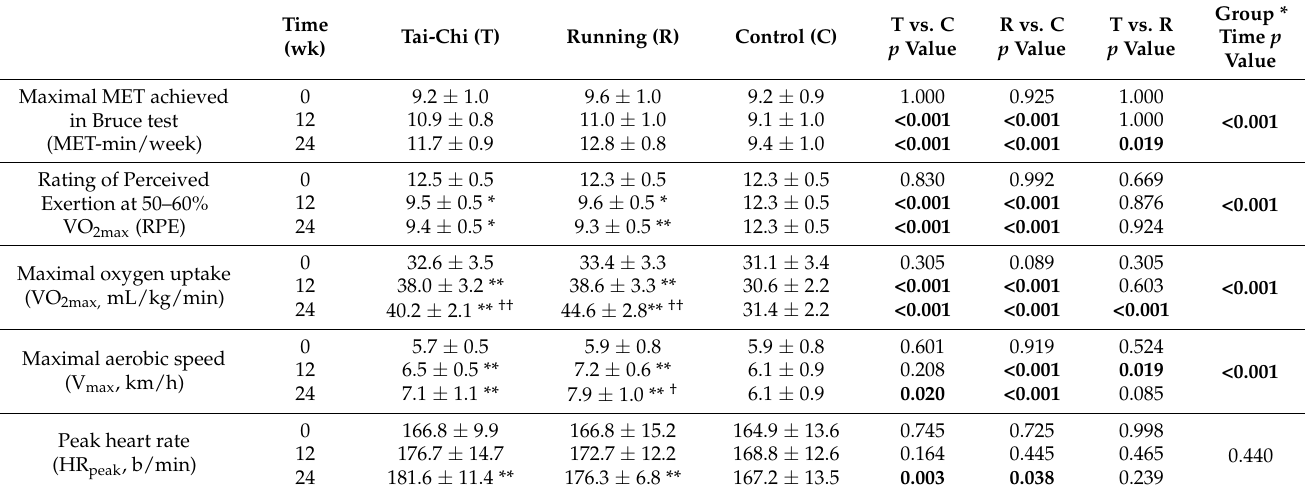
Table 4. Maximal oxygen uptake, maximal aerobic speed and peak heart rate among Tai-Chi ( n = 10), running ( n = 14) and control ( n = 12) groups at baseline, 12-week and 24-week intervention (mean ± SD). Time Tai-Chi (T) Running (R) Control (C) (wk)